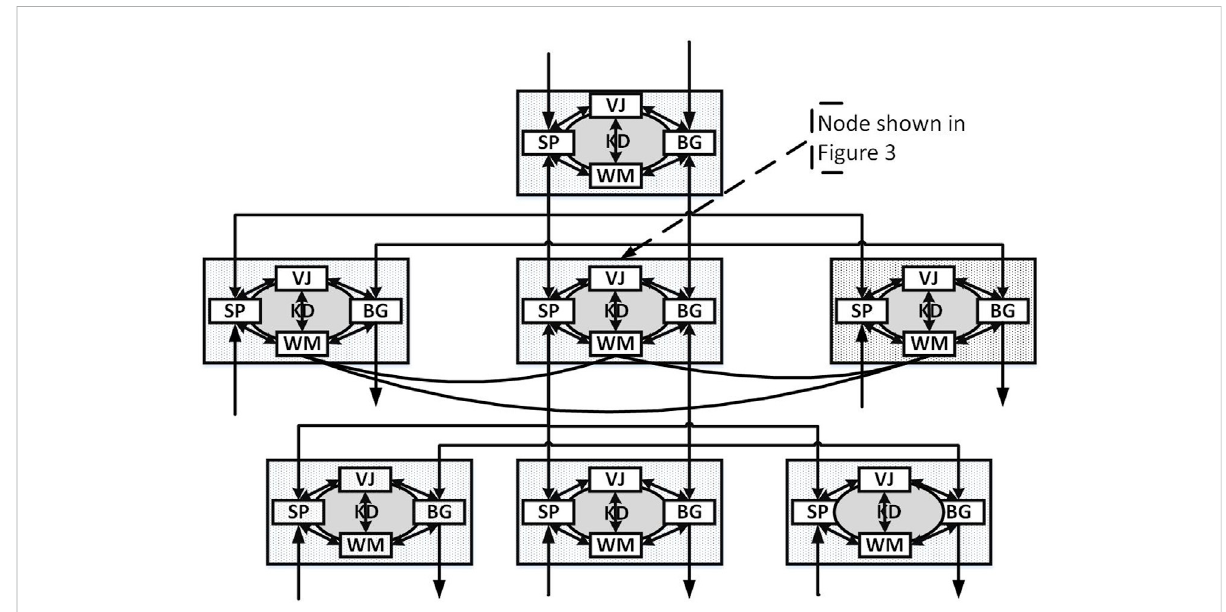
FIGURE 4 Showing the connections between nodes in each position in the hierarchy in Figure 3A 4D/RCS node and connected nodes. Key: Value Judgement (VJ), Behaviour Generator (BG), Sensory Processing (SP), World Modelling (WM), Knowledge Database (KD).